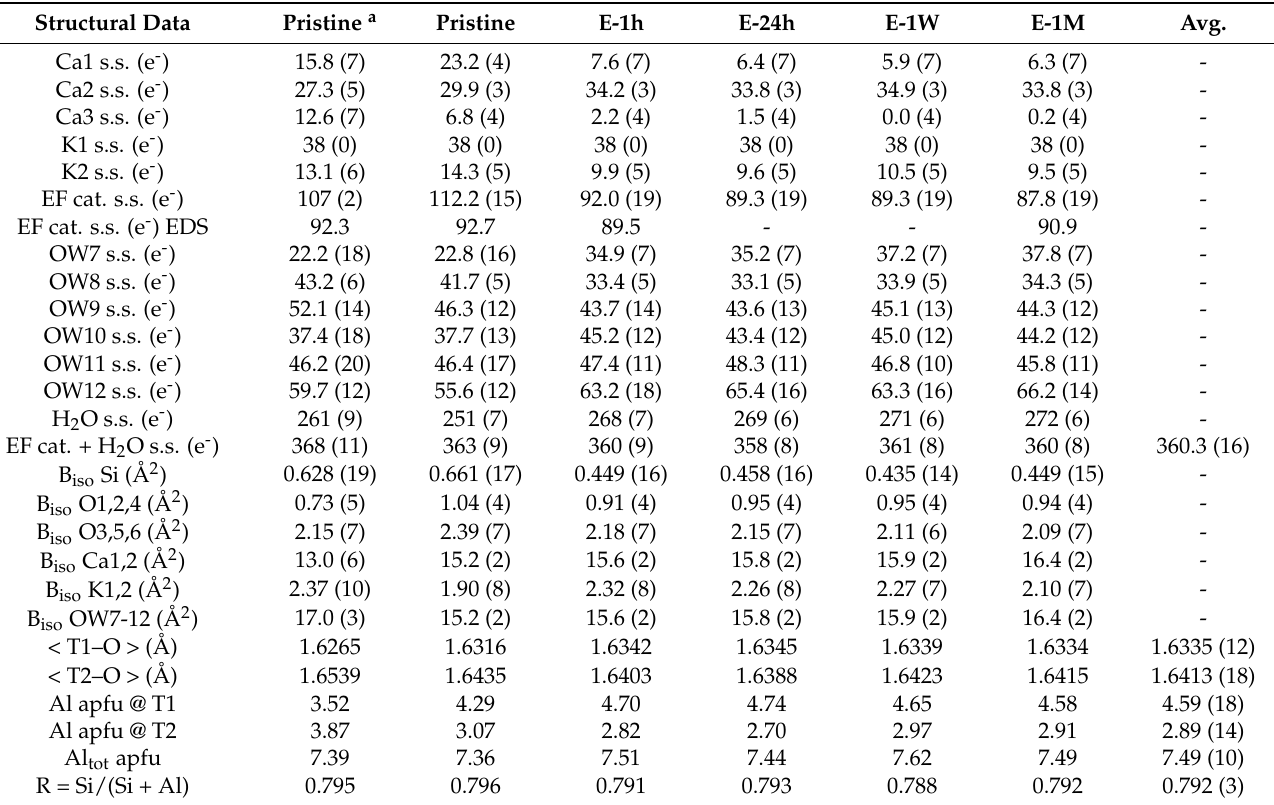
Table 2. Relevant structural data of the mixed Pawley–Rietveld refinements. Al population at T1 [Al(1)] and T2 [Al(2)] tetrahedral sites as calculated from the Jones’ determinative curves: Al pop = 6.4116 × < T–O > − 10.282. Tabulated values were multiplied by the site multiplicity (T1 = 24; T2 = 12). Avg. refers to average values calculated for the 5